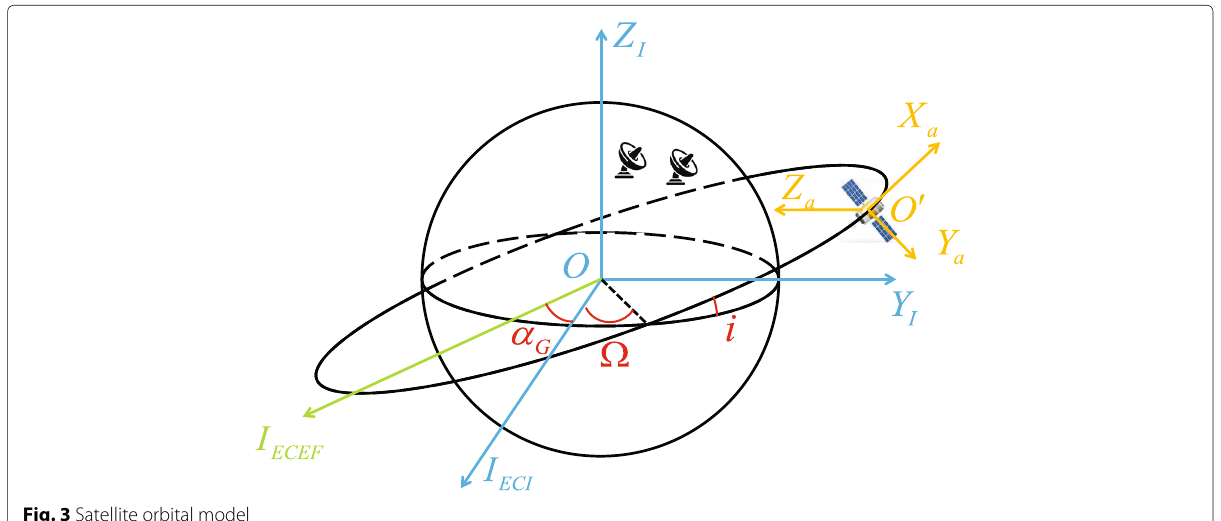
Fig. 3 Satellite orbital